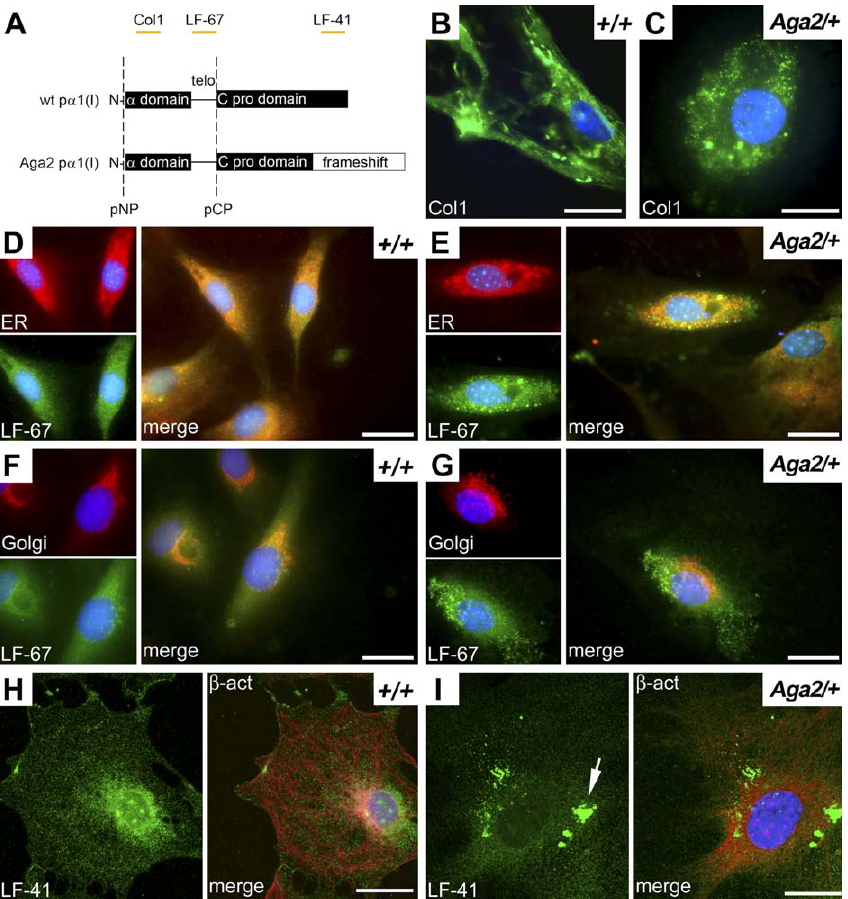
Figure 4. Immunofluorescence Microscopy of Type I and pro a 1(I) Collagen in Aga2/ þ Primary Dermal Fibroblasts (A) Scheme depicting probe-specificity toward various isoforms (pN/CP, procollagen N/C-proteinase; telo, telopeptide domain). (B,C) Mature type I collagen. (D-G) Pro a 1(I) double immunofluorescence using antiserum LF-67, protein disulphide isomerase (PDI), and golgi phosphoprotein 4 (GOLPH4) for detection of the ER and cis -Golgi apparatus, respectively. The combined panels (E) and (G) show pro a 1(I) chain retention within the ER, not in the cis - Golgi respectively, when compared to controls (D,F). It is speculated that aberrant procollagen molecules aggregate into vesicular structures (E) (merged green dots), which may be part of the proteasome. (H,I) Pro a 1(I) double immunofluorescence using antiserum LF-41 and b -actin antibody for the cytoskeleton (arrow, aberrant procollagen). All nuclei were counterstained with DAPI. Bars, 25 l